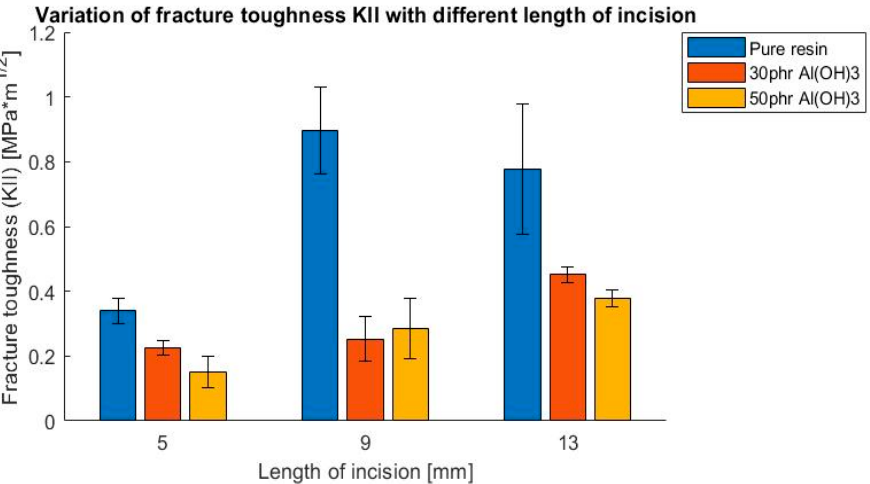
Figure 12. Variation of fracture toughness K I with different lengths of incision, 4 ‐ point bending test.